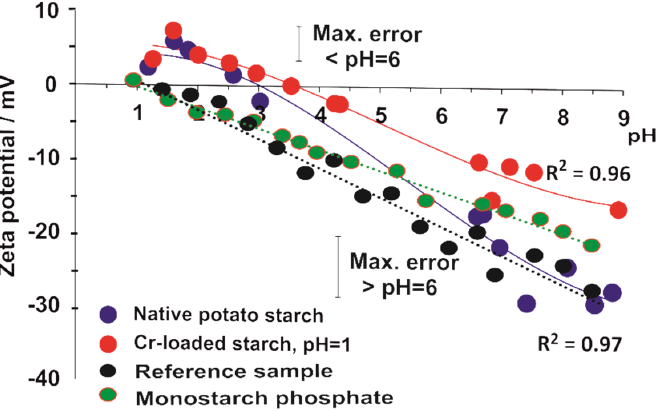
Figure 2. The effect of pH on the zeta potential of native and modified potato starch.